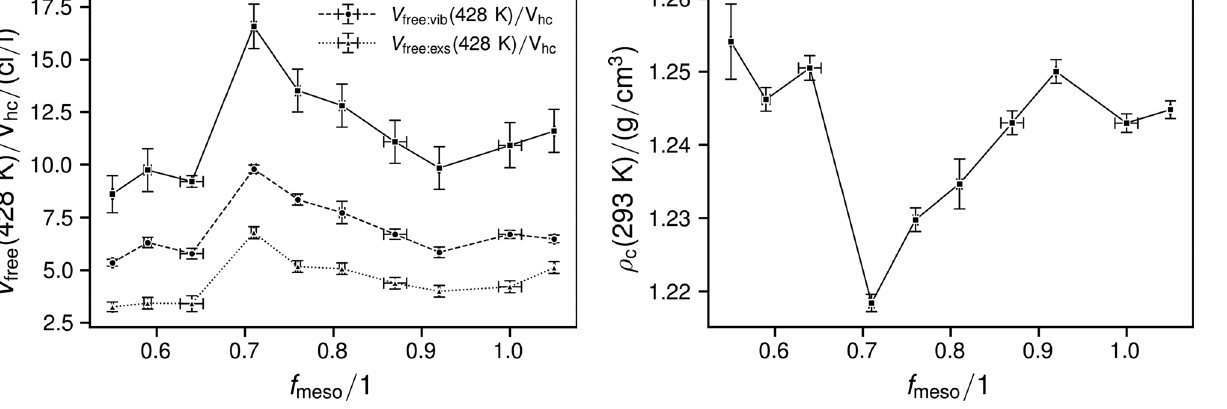
Figure 13: Crystalline phase densities at room temperature, as cal - culated by equation ( 18